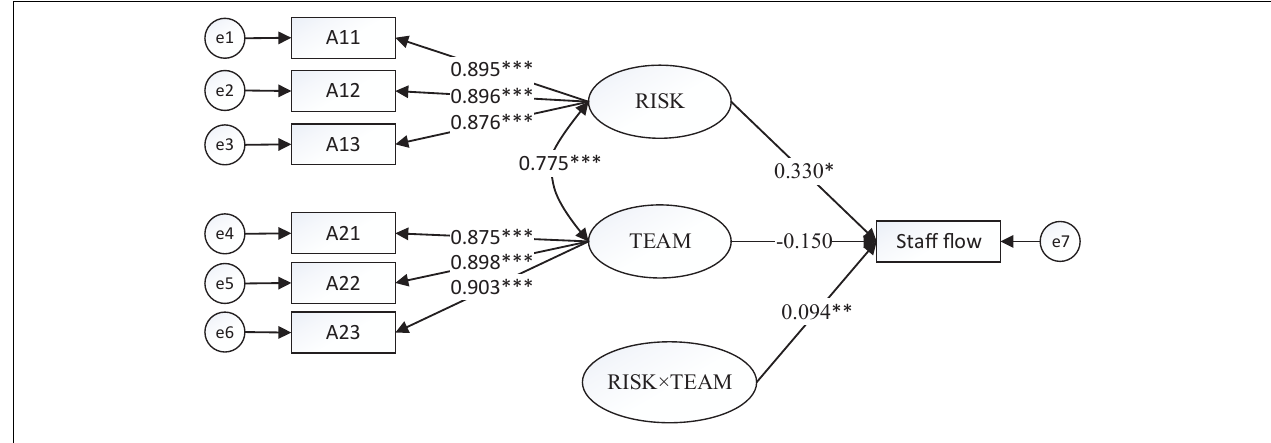
FIGURE 4 | Moderating effect of TEAM on staff flow. ∗ p < 0.05, ∗∗ p < 0.01, ∗∗∗ p <